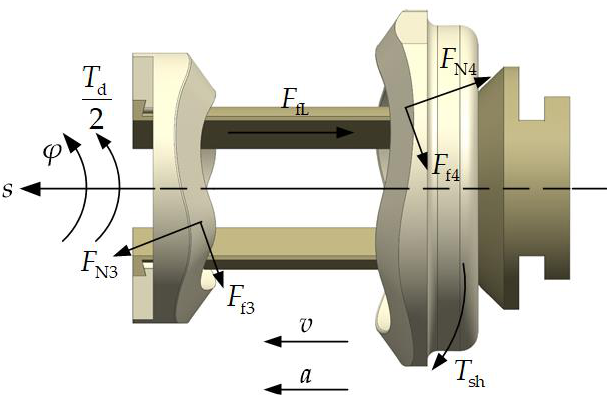
Figure 8. Force analysis of the cam rail set II.